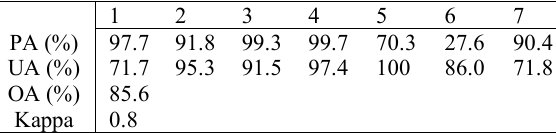
Table 3.2. Results obtained for 2016-year classification. PA: Producers Accuracy; UA: User’s Accuracy; OA: Total precision and Kappa classification.